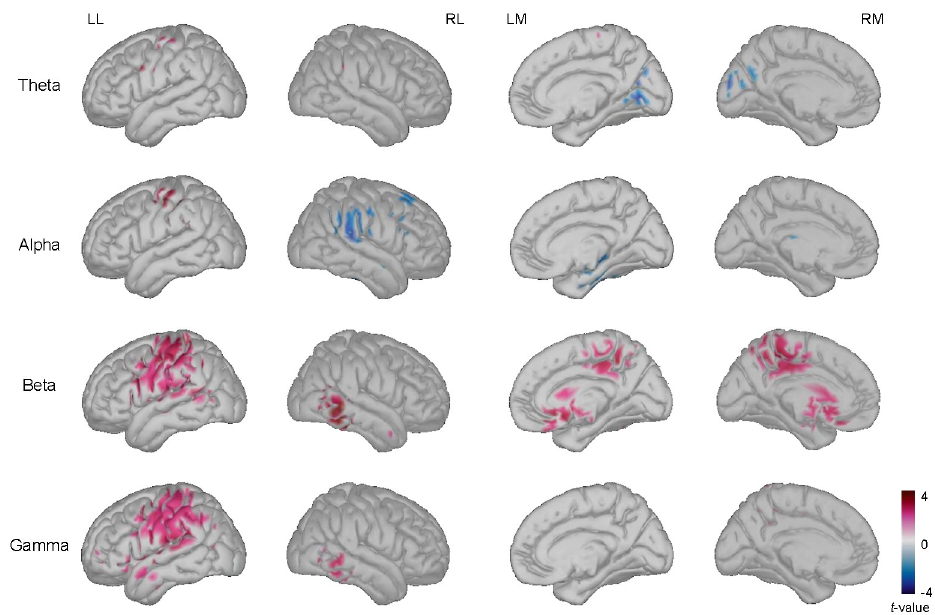
Fig 5. Significant difference between power of later remembered items vs. forgotten items during encoding task prior to the presentation of the stimulus. The t -values in theta, alpha, beta, and gamma bands when comparing remembered items to forgotten items during -300–0 ms prior to the presentation of the stimulus (two-tailed paired t - test, p < 0.05 with Bonferroni correction). LL = left lateral view; RL = right lateral view; LM = left medial view; RM = right medial